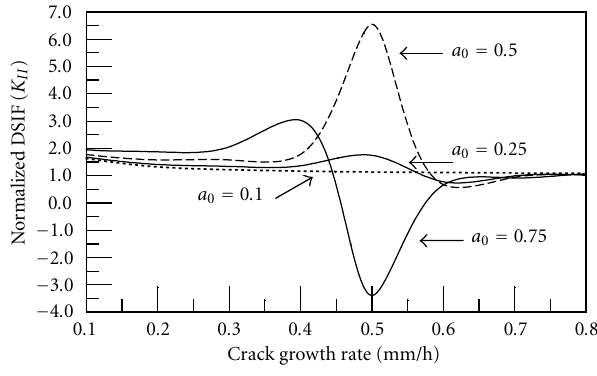
Figure 4.2. Variation of the normalized K II with the crack growth rate and initial crack length.